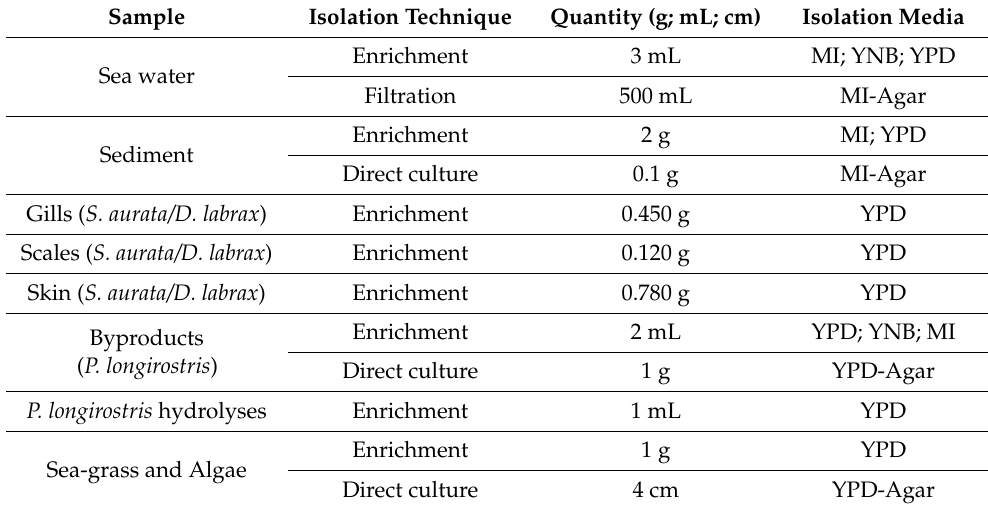
Table 1. Procedure of yeast